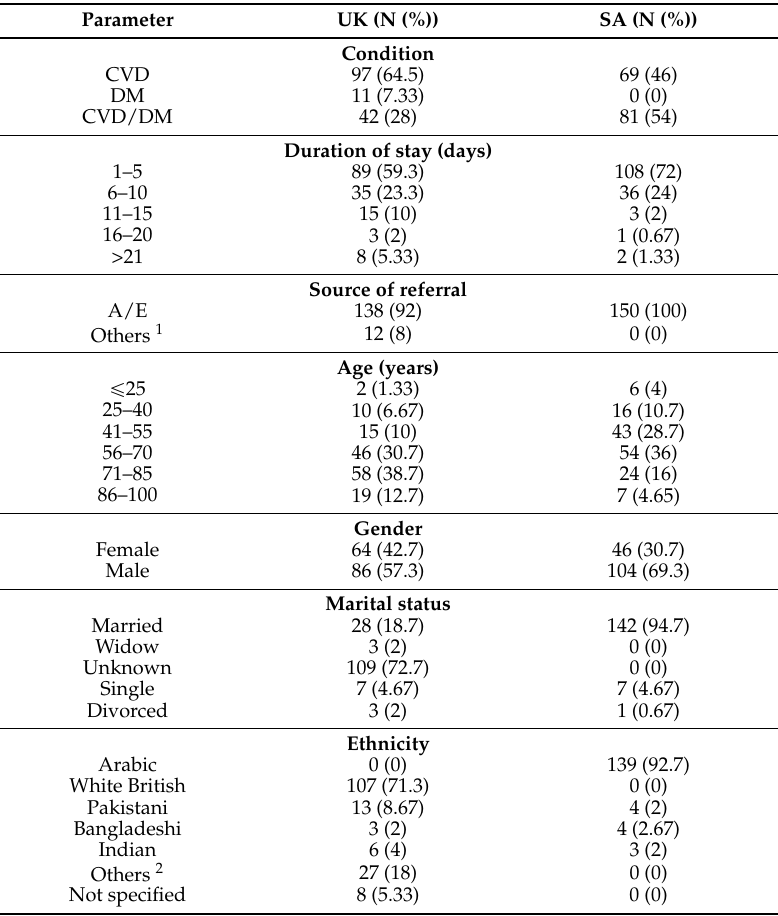
Table 1. Demographic information of the patients included in this